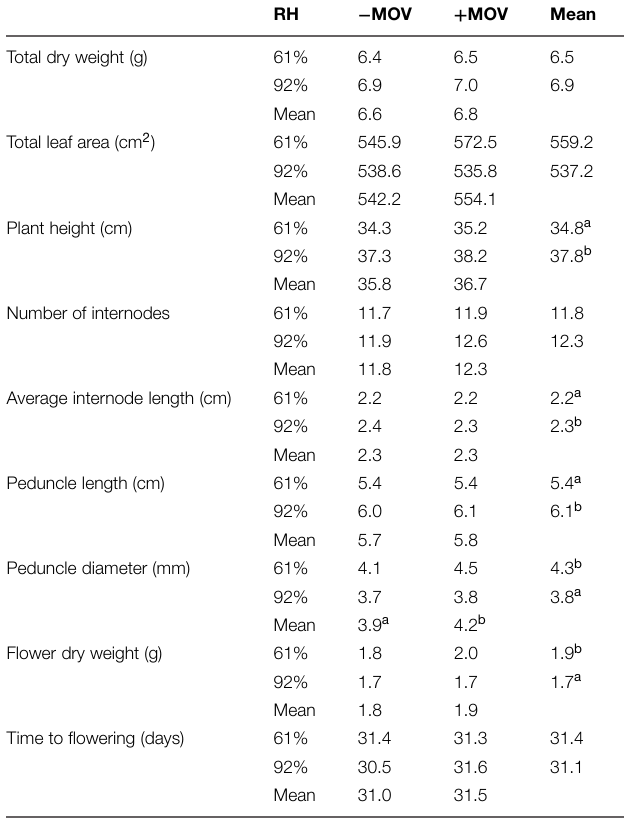
TABLE 1 | Plant growth and visual quality parameters in fully developed plants (i.e., flower bud with cylindrical shape and pointed tip) of pot